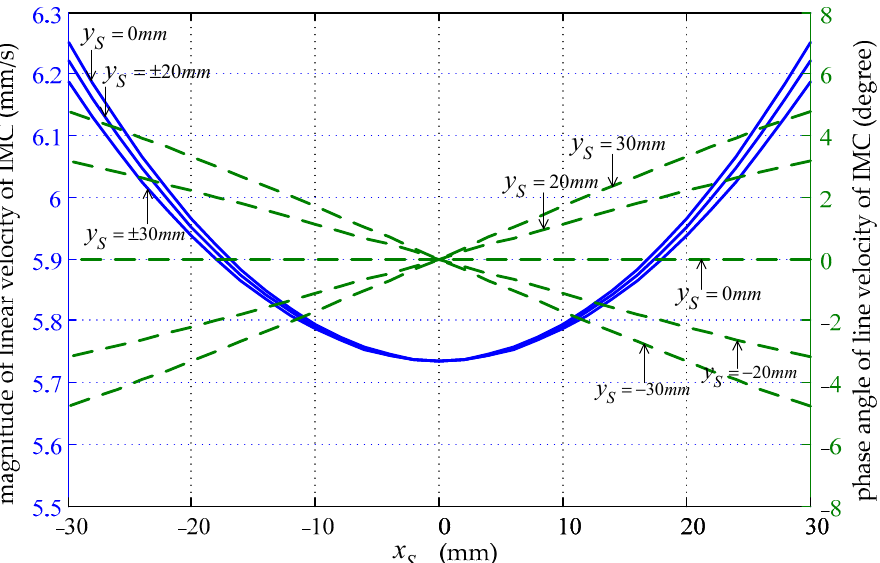
Figure 10. Magnitude or phase angle of the linear velocity of the IMC with a position on the sensor plane.